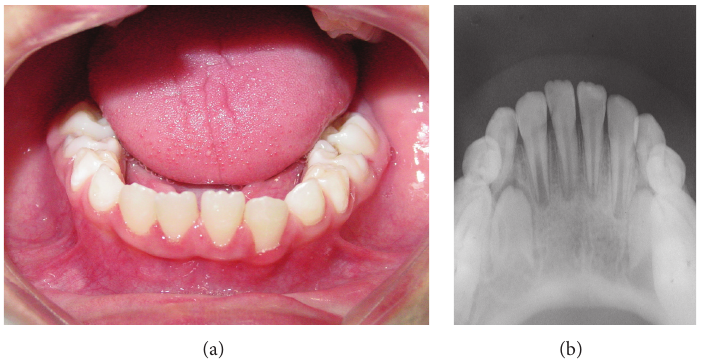
Figure 5: (a) Clinical aspect after removal of the splint showing the normality of soft tissues. (b) Radiographic image without splint (after 6 weeks of the trauma) indicating no pulp and periodontal